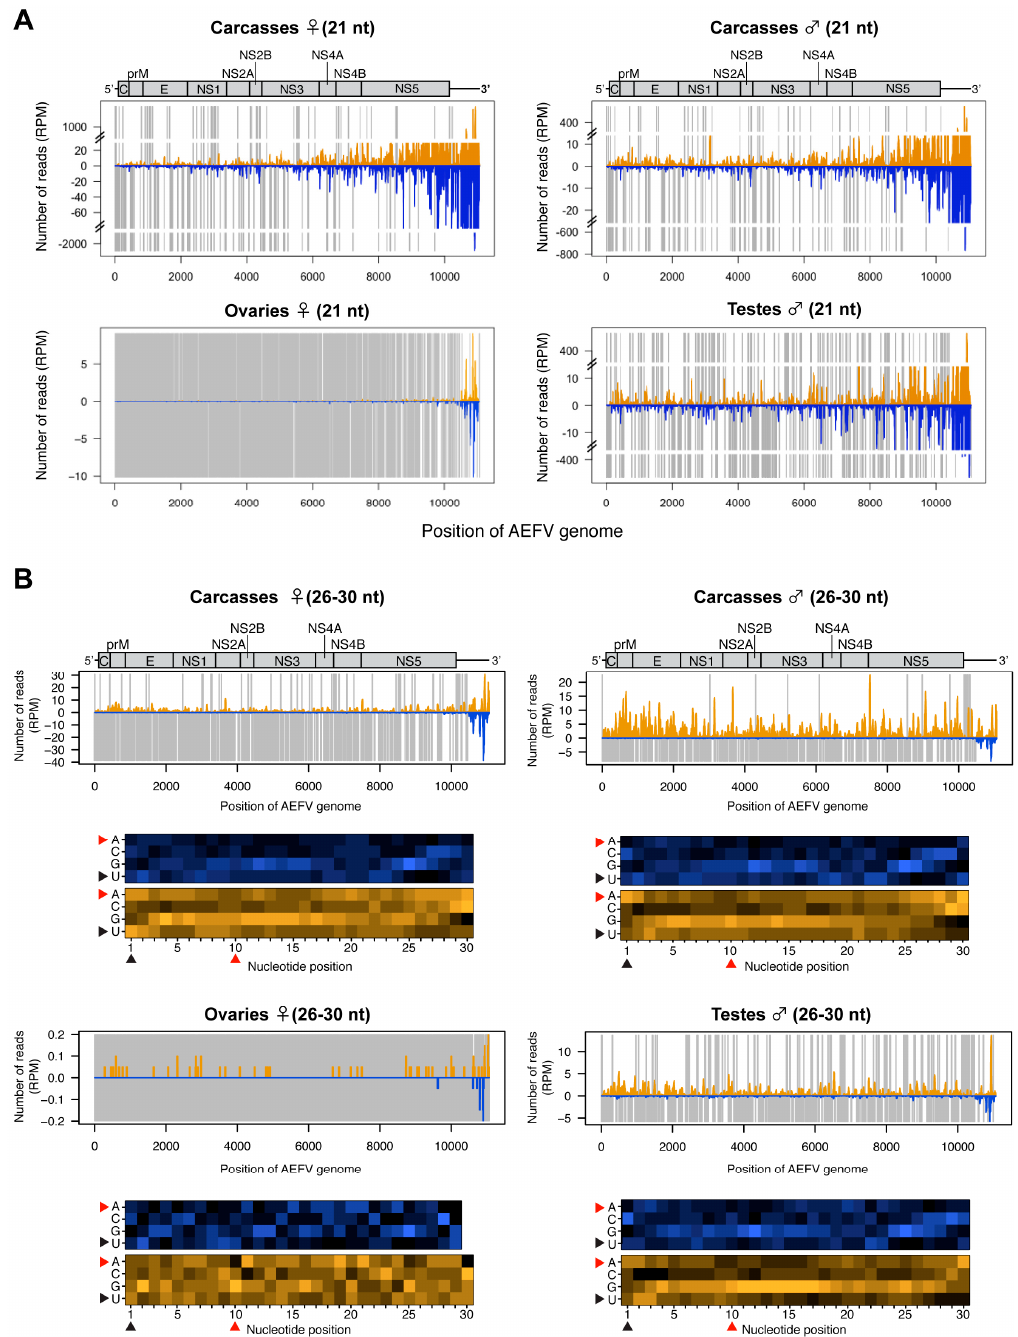
Figure 3. Small RNA responses to AEFV in female and male Ae. albopictus reproductive tissues and carcasses. The distribution of siRNA (21 nt) ( A ) and piRNA-like small RNAs (26-30 nt) (upper panel, B ) mapped to the AEFV genome. A schematic illustration of the AEFV genome is shown on top of small RNAs mapping to the viral sequence. Yellow and blue bars represent positive- and negative-stranded reads, respectively. Regions with no coverage are indicated by gray bars. For AEFV-derived 26-30 nt piRNA-like small RNAs, relative nucleotide frequency at each position is shown as a heat map (lower panel in B) in which the color intensity denotes the frequency. The black and red arrowheads point to the 1U and 10A positions, respectively.